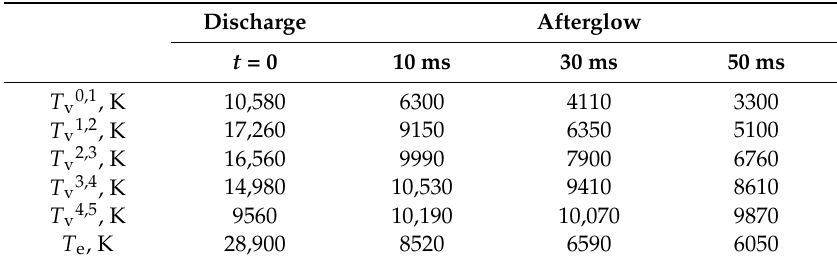
P = 5 Torr, T gas = 350 K, I = 20